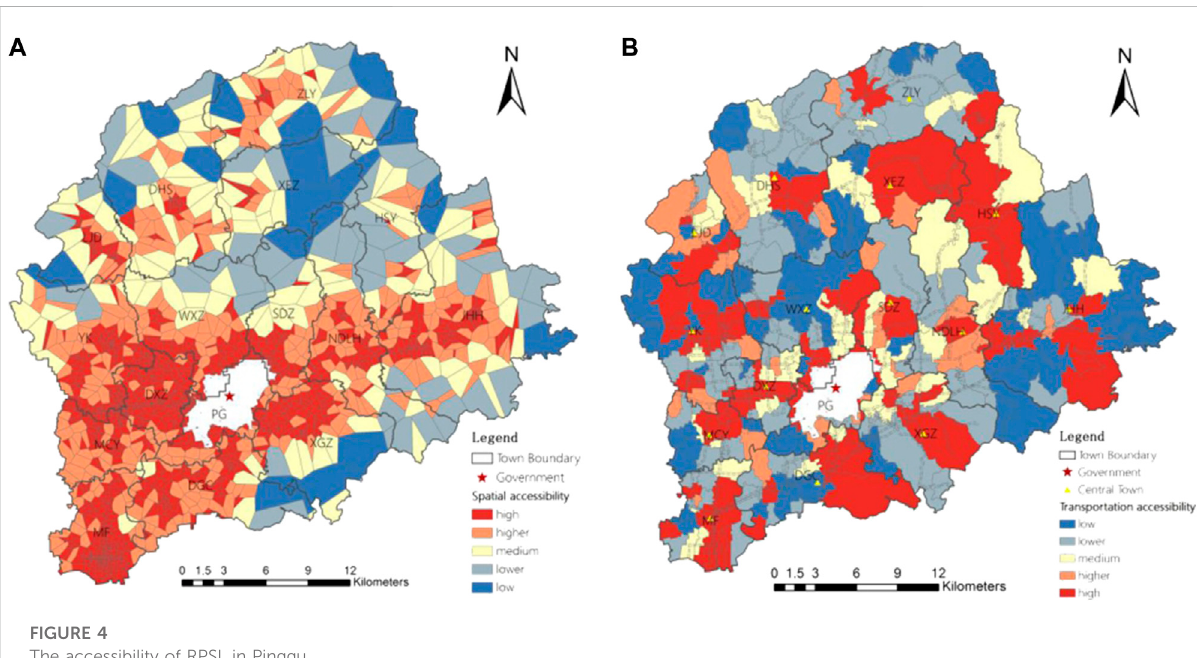
FIGURE 4 The accessibility of RPSL in